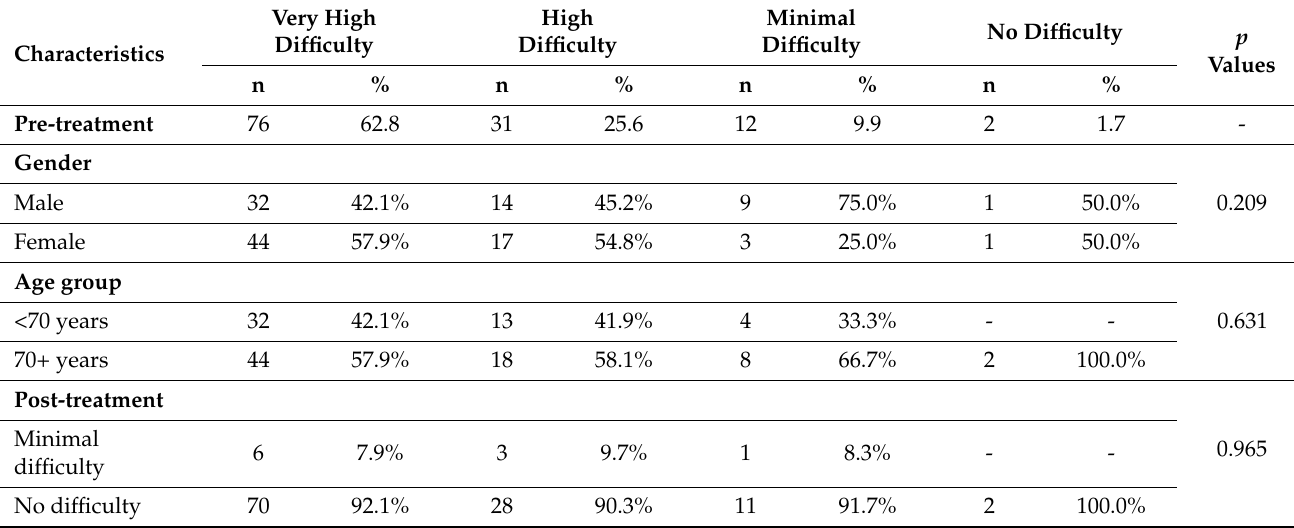
Table 5. The percentage distribution of patients with vision difficulties walking on uneven ground according to pre- and post-treatment study group characteristics.